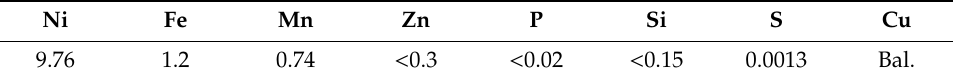
Table 1. Composition (wt%) of the experimental 90 / 10 copper-nickel alloy sheet. Ni Fe Mn Zn